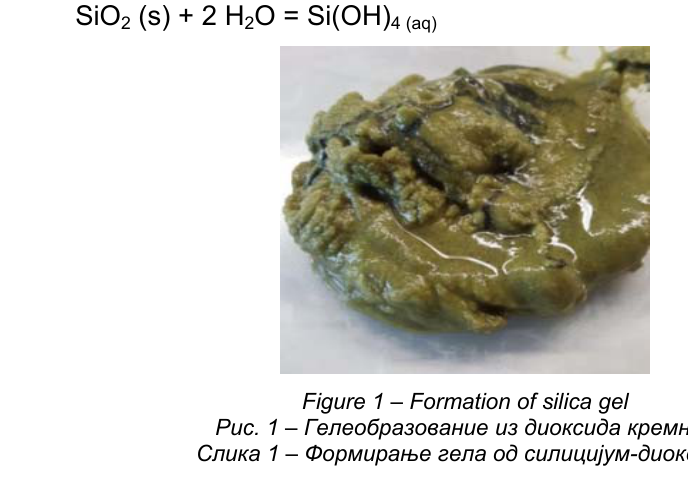
Figure 1 – Formation of silica gel Рис . 1 – Гелеобразование из диоксида кремния Слика 1 – Формирање гела од силицијум -